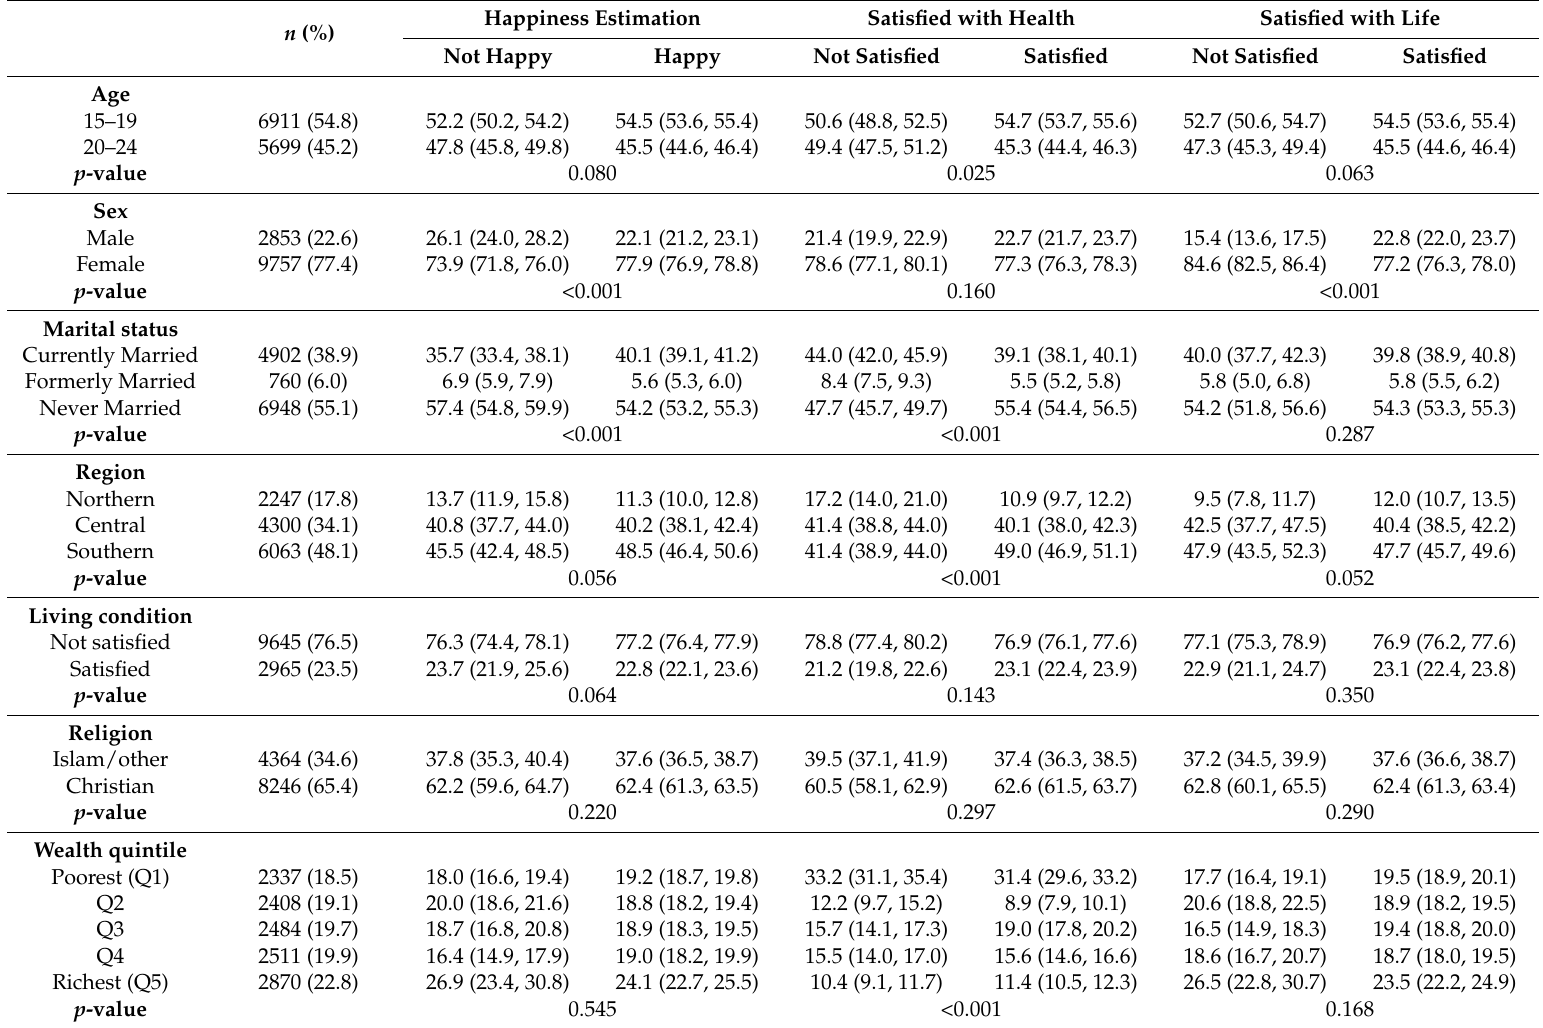
Table 1. Sample characteristics. n =